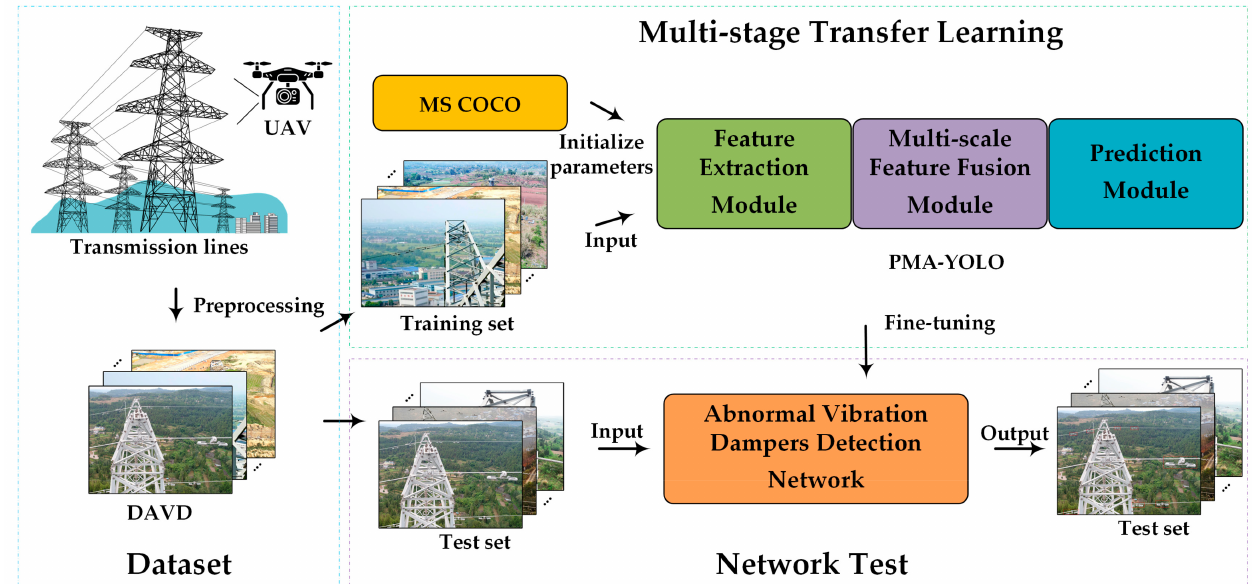
Figure 17. Schematic framework of our abnormal vibration damper detection